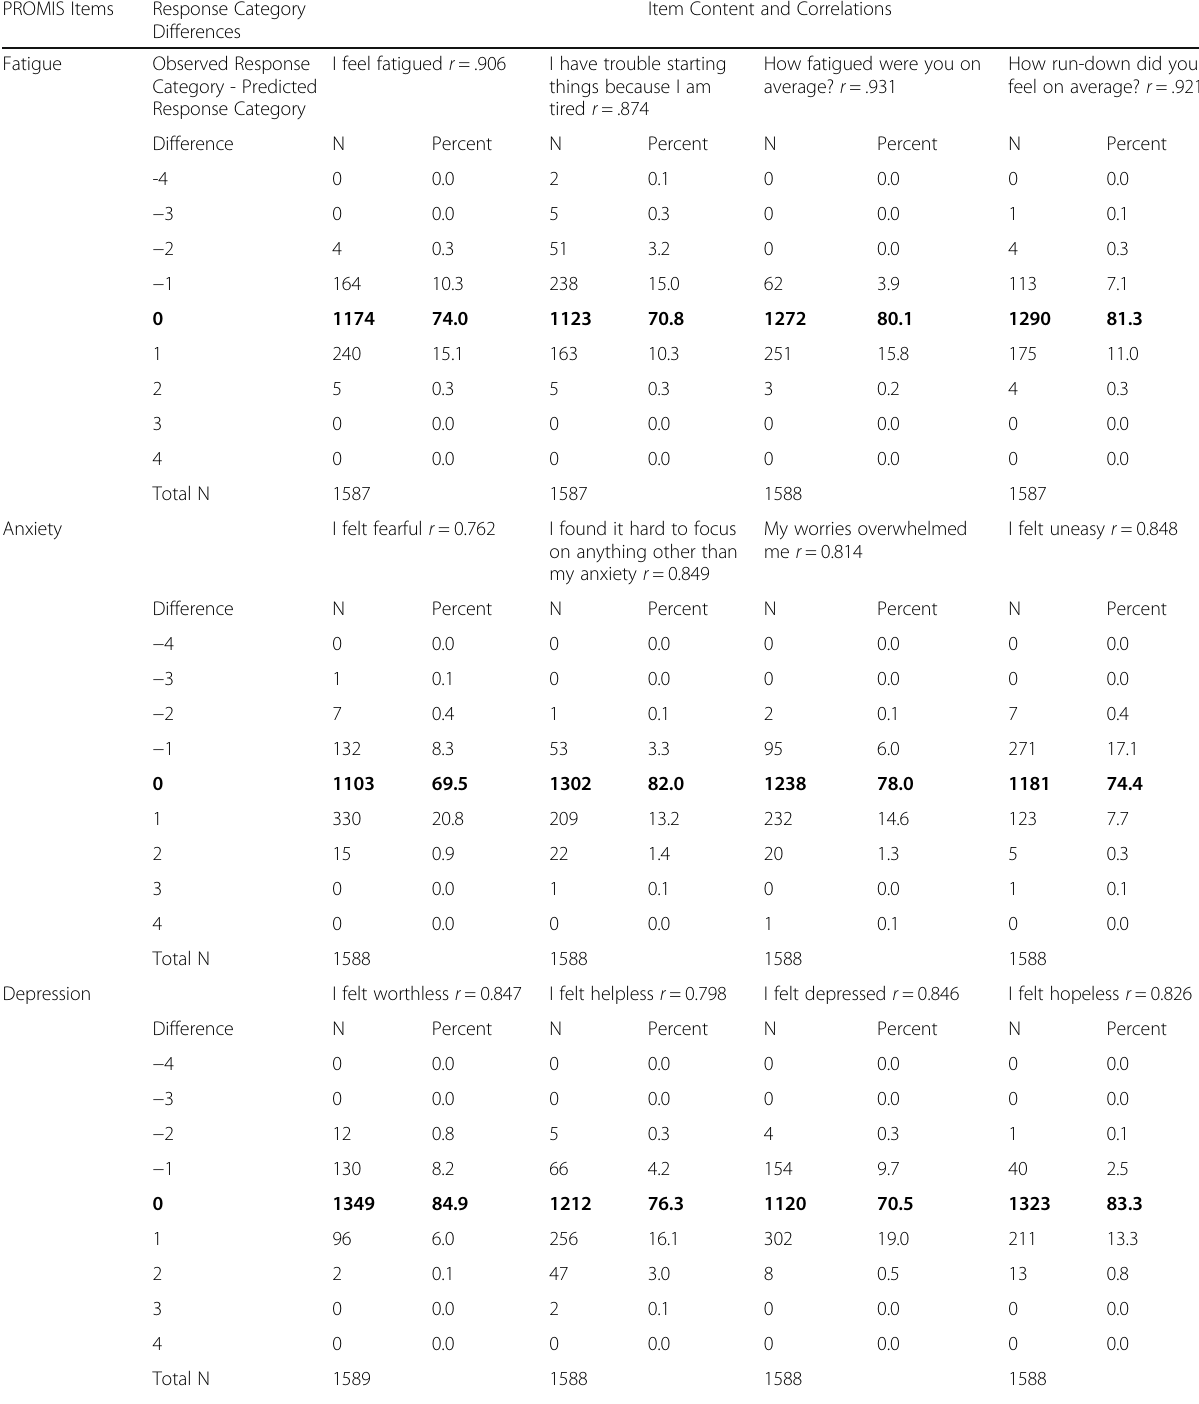
Table 2 Differences scores (observed - predicted response category) and Spearman correlations between observed and predicted